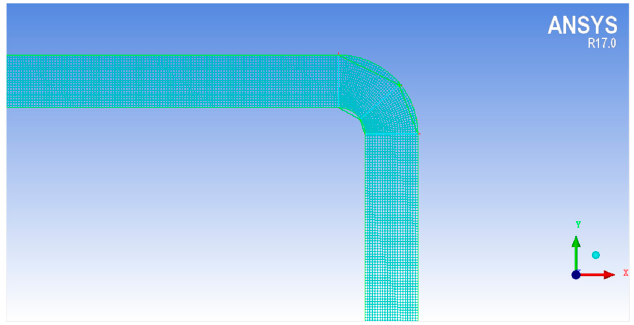
Figure 2. The local mesh of the CFD model.